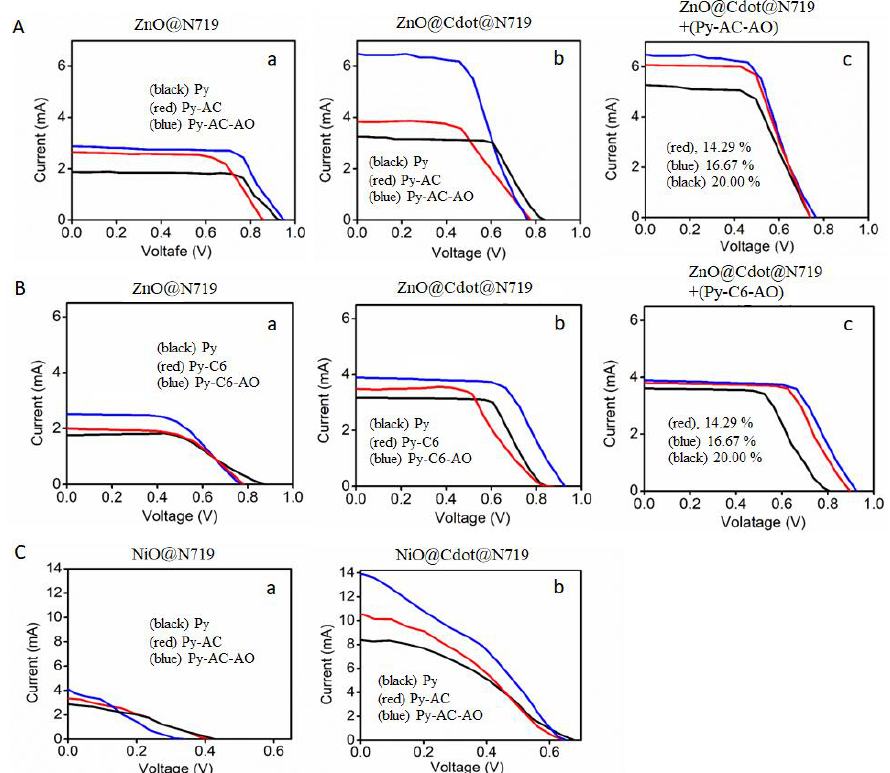
Figure 7. I – V curves of cascade FRET DSSCs. ( A ) ( a ) ZnO@N719 and ( b ) ZnO@Cdot@N719 under addition of FRET dyes; (black) Py, (red) Py-AC, and (blue) Py-AC-AO. ( c ) ZnO@Cdot@N719 + (Py-AC-AO) at different FRET dye concentrations; red: 14.3wt%, blue: 16.7wt%, black: 20.0wt%. ( B ) ( a ) ZnO@N719 and ( b ) ZnO@Cdot@N719; (black) Py, (red) Py+C6, (blue) Py+C6+AO.